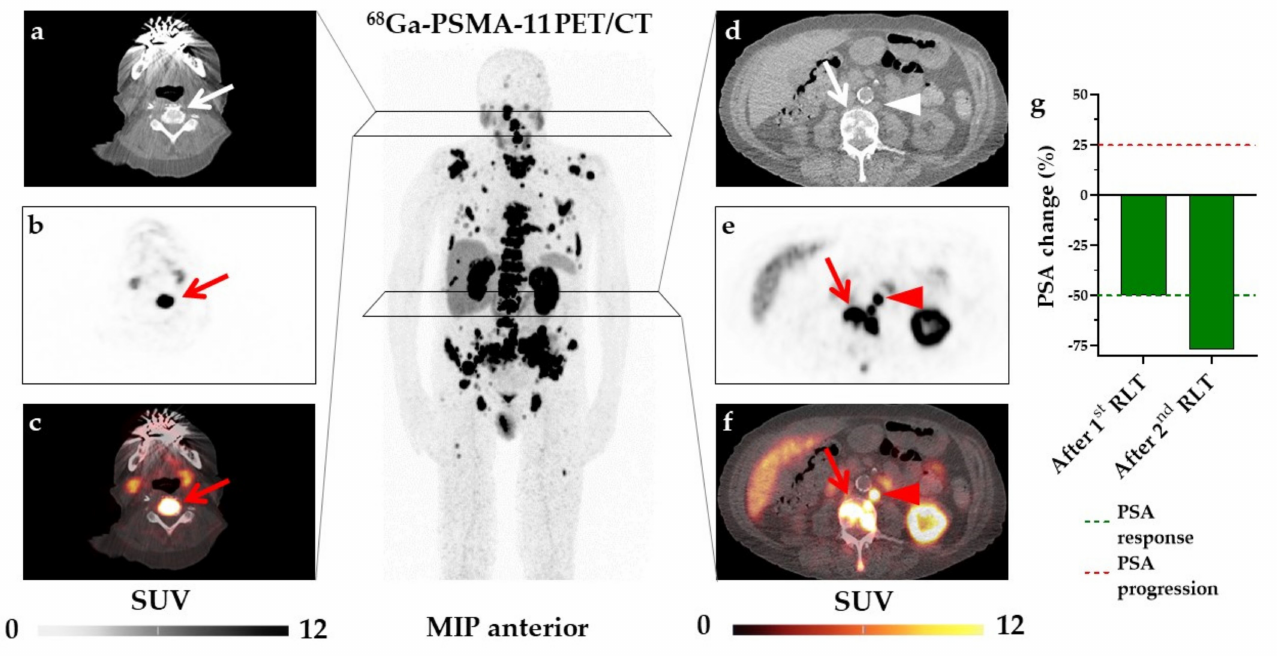
Figure 3. Case example of a responder. Representative metastases in the 4th cervical vertebra (arrow, SUV max = 62.85, PSMA-TV = 2.9 cm 3 ) on transaxial CT ( a ), PET ( b ) and fused 68 Ga-PSMA-11 PET/CT ( c ), the 3rd lumbar vertebra (arrow, SUV max = 91.1, PSMA-TV = 5.56 cm 3 , d – f ) and a paraaortic lymph node (arrowhead, SUV max = 59.95, PSMA-TV = 0.33 cm 3